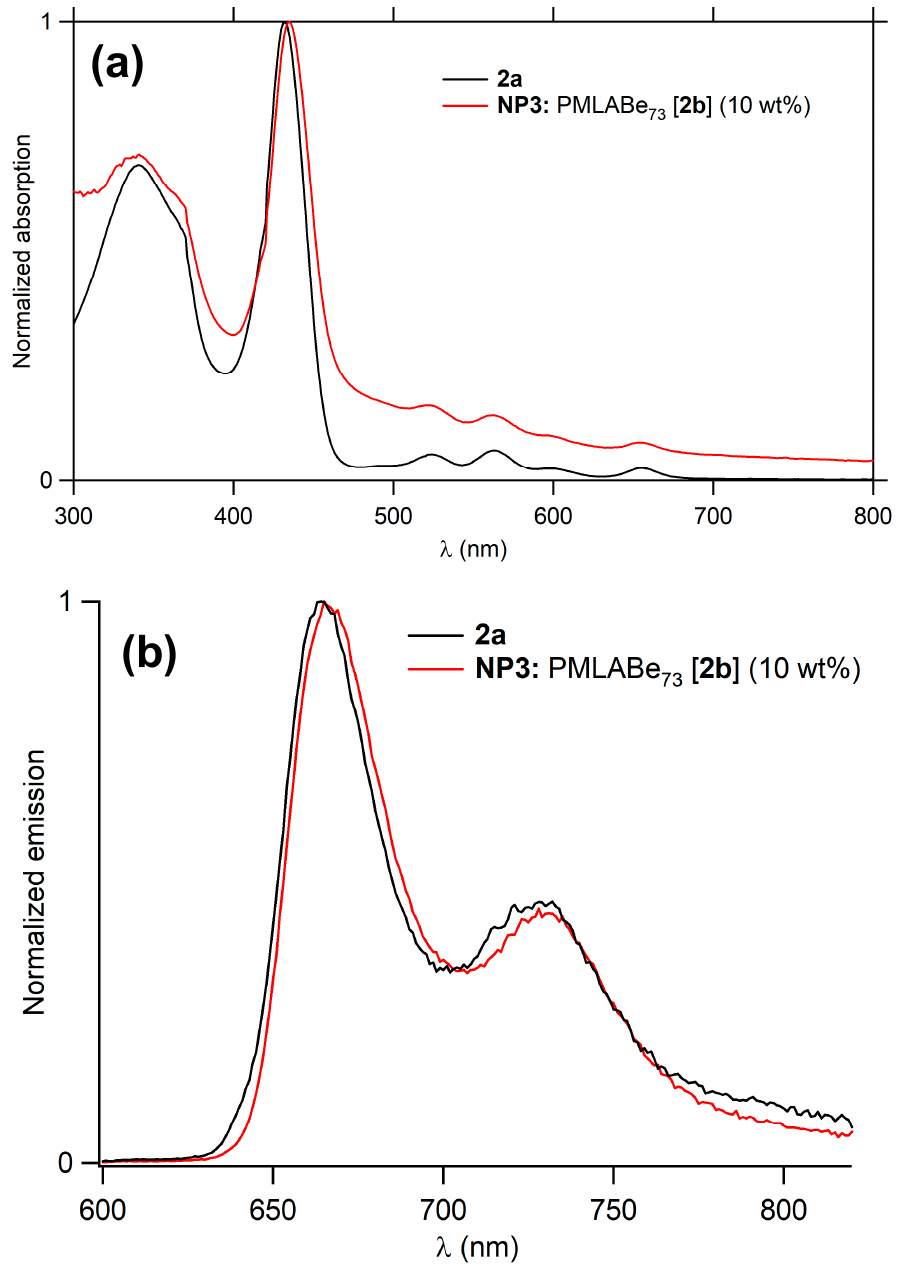
Figure 2. Comparison of UV-Vis spectra of 2a and of NP3 incorporating 10 wt% of 2b in water ( a ). Comparison of the emission spectra of 2a and of NP3 incorporating 10 wt% of 2b in water ( b ). To evaluate the actual concentration of porphyrin encapsulated in the NPs, the por- phyrins were first fully released in solution by addition of THF to the water suspensions of NPs. After determining the molar extinction coefficients of porphyrins 1b and 2b alone dis- solved in [90:10] THF/water mixtures (ESI), the absorption spectra of porphyrins released from NPs in the same [90:10] THF/water mixture were measured, allowing to calculate the porphyrin concentrations and finally to derive the experimental porphyrin loadings in NPs (Table